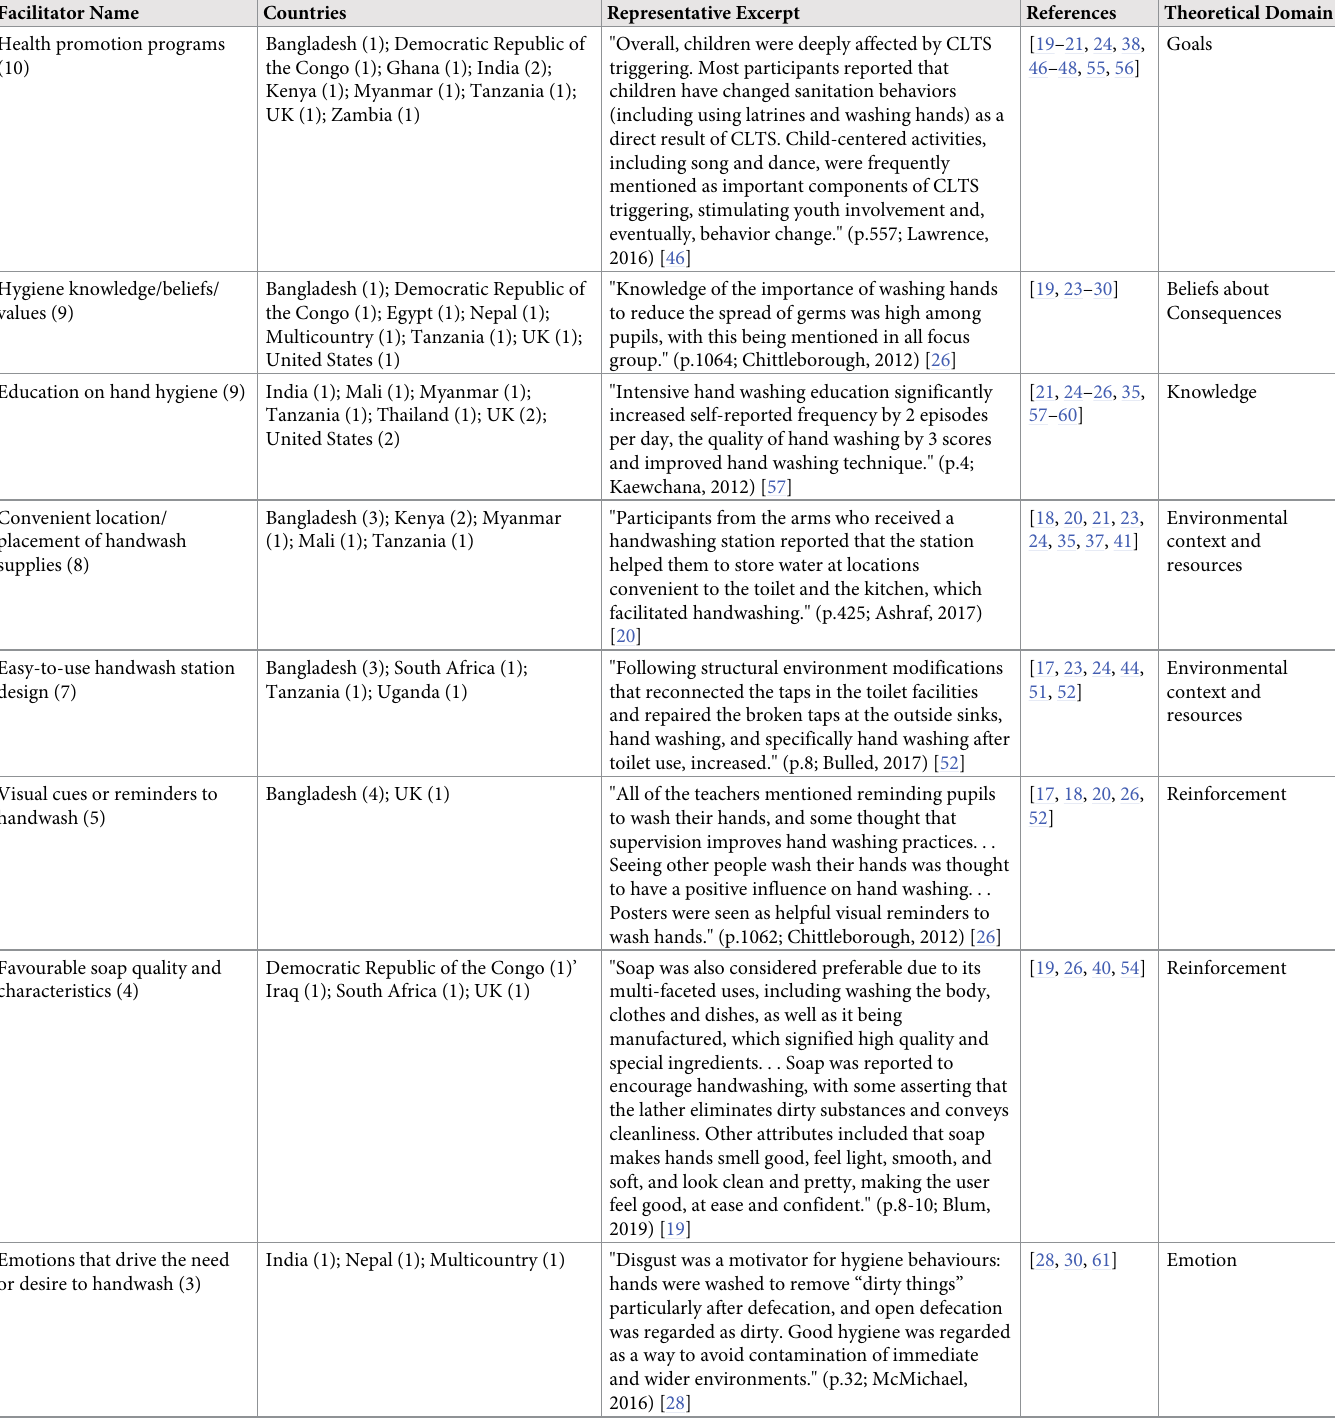
Table 3. Facilitators identified from the 46 studies categorized into domains of the Theoretical Domains